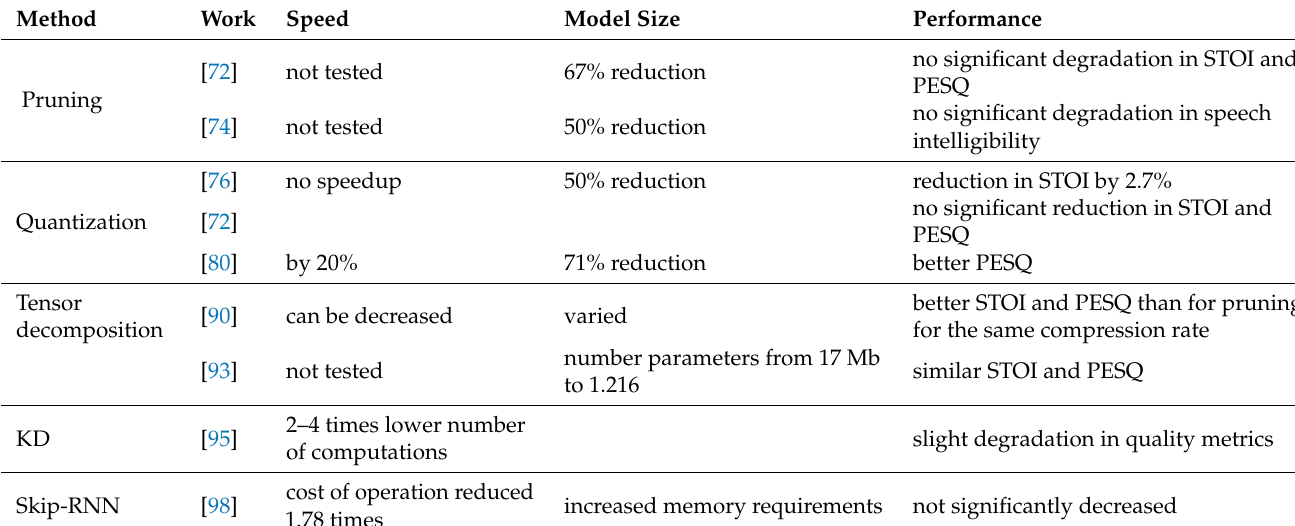
Table 3. Comparison of the properties of the compression